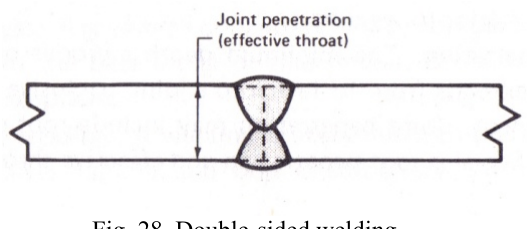
Fig. 27. Bevel design for manual and automated welding